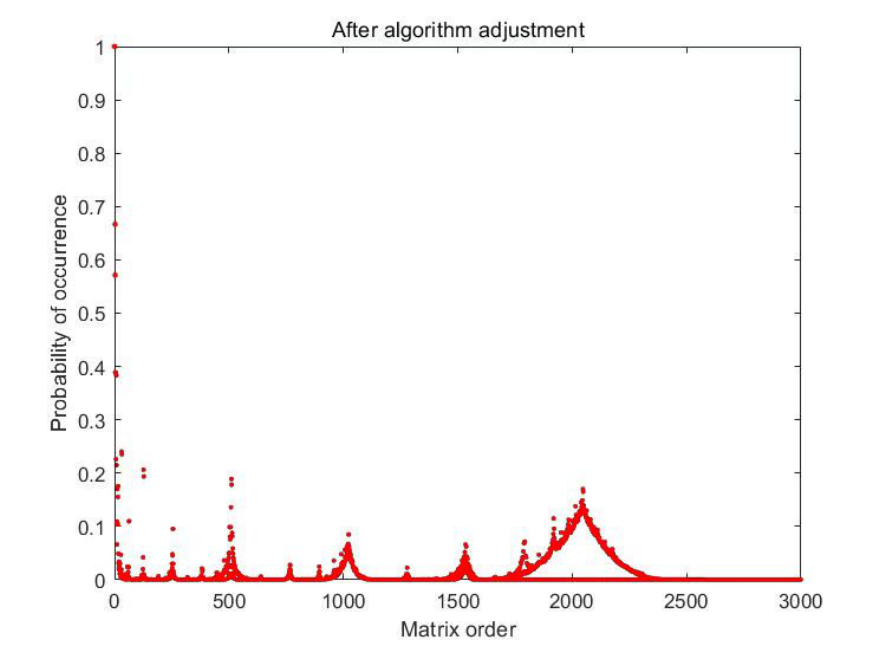
Figure 10. Occurrence probability of the offset sequences in the range of 3000-order matrices, where the horizontal axis is the order of the matrices and the vertical axis is the occurrence probability of the offset sequences in 5000